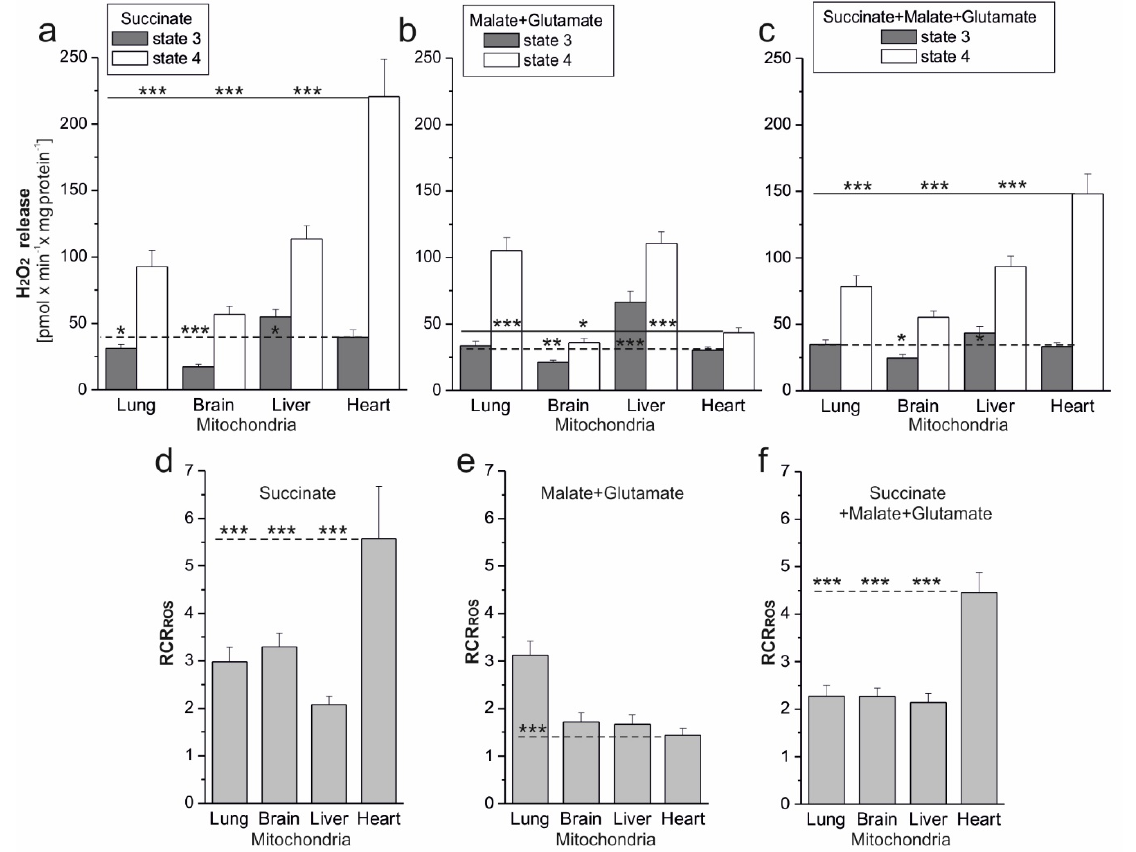
Figure 2. H 2 O 2 release in isolated rat mitochondria oxidizing succinate ( a ), malate plus glutamate ( b ) and a mixture of succinate and malate plus glutamate ( c ) under phosphorylating (state 3) and nonphosphorylating (state 4) conditions. RCR ROS , respiratory control ratio of mROS formation (state 4 H 2 O 2 formation/state 3 H 2 O 2 formation) with various respiratory substrates ( d–f ). Mean ± SD; n = 5. p < 0.05 (*), p < 0.01 (**), or p < 0.001 (***), comparison vs. mean values for heart mitochondria.